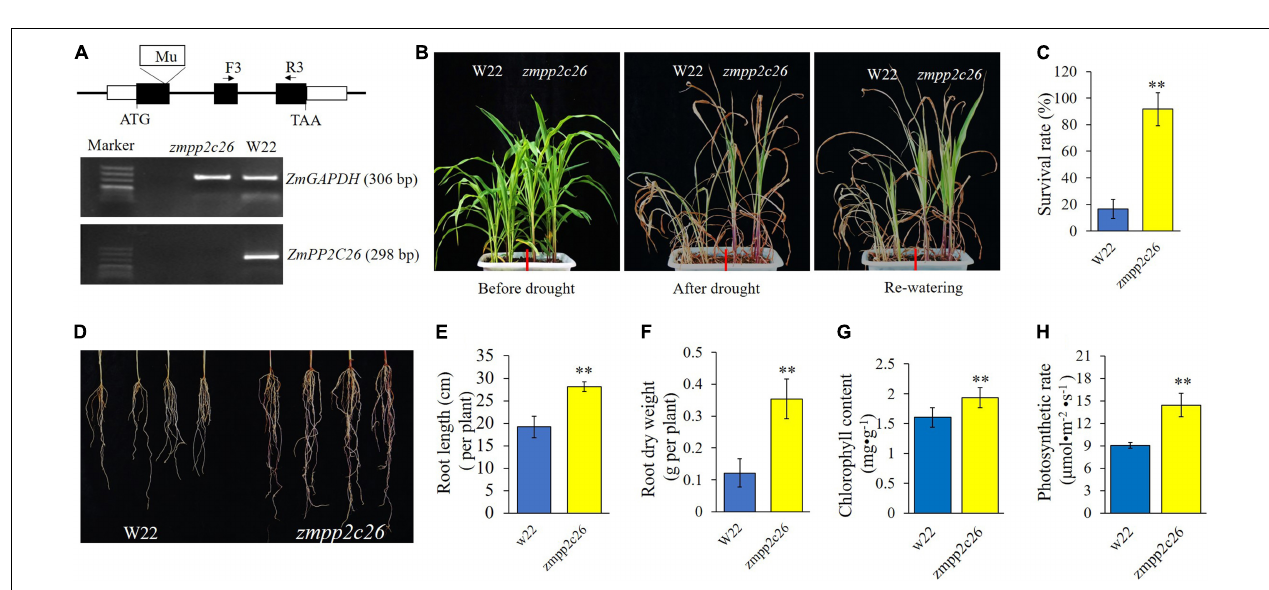
FIGURE 5 | Phenotyping of transgenic rice lines under drought stress. (A) Wilting phenotype of every line. Three-week-old seedings were subjected to drought treatment by withholding watering for 2 weeks, then re-watered for 3 days and photographed. (B) The survival rate of every line after treatment. (C,D) Chlorophyll content and photosynthetic rate of every line before treatment. (E) Root phenotype of every line. After germination, seedlings were transferred into plastic net pots and cultured in 20% PEG solution for 3 days. (F) Root length. WT, wild type; L1 and L2, ZmPP2C26L- overexpressing lines; S1 and S2, ZmPP2C26S- overexpressing lines. ∗ P < 0.05; ∗∗ P < 0.01.